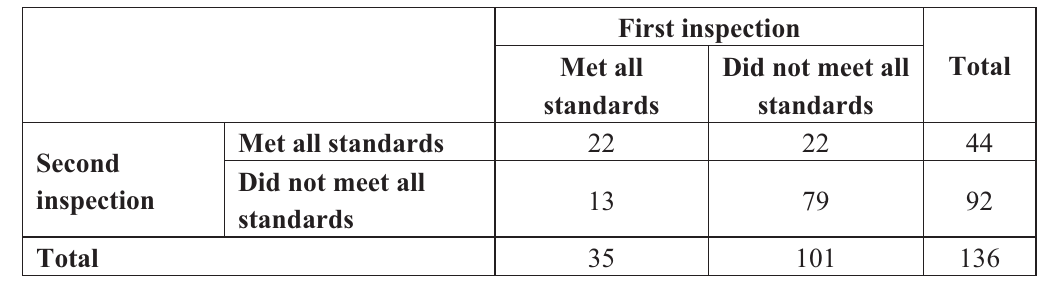
Table 1. Comparison of zoo assessments at first and second